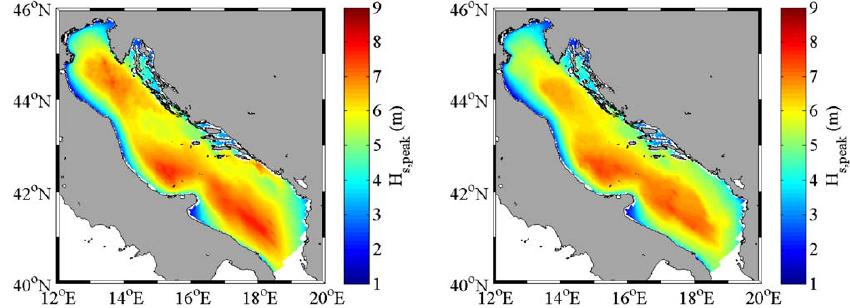
Fig. 13. 30-yr return significant wave height H s (in meters). Numerical simulations of the present climate (left) and the future scenario (right) are